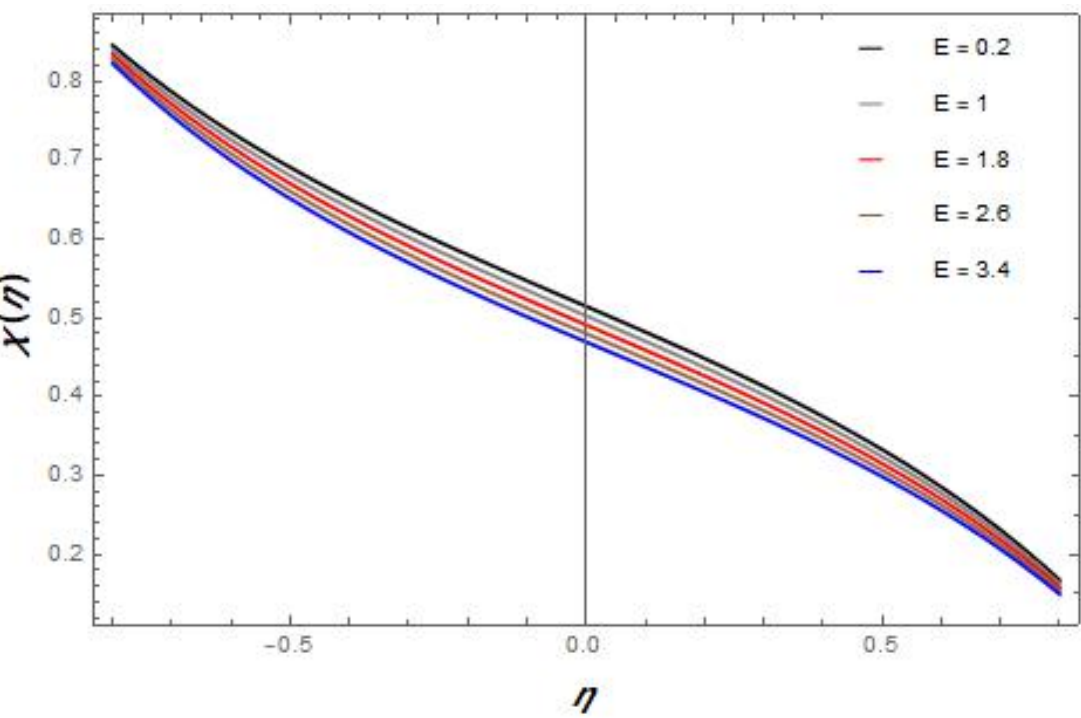
Figure 2. Effect of the magnetic parameter on velocity 𝑓 (cid:4593) .